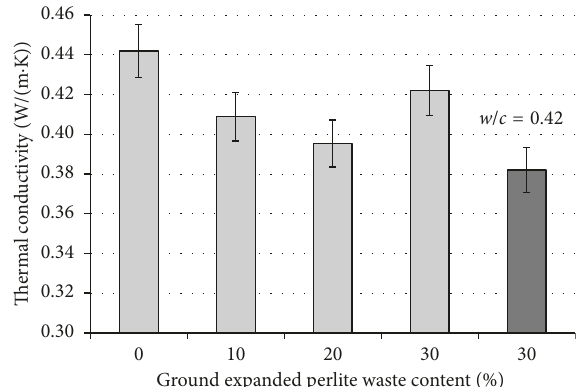
Figure 3: Bulk density of cement pastes.